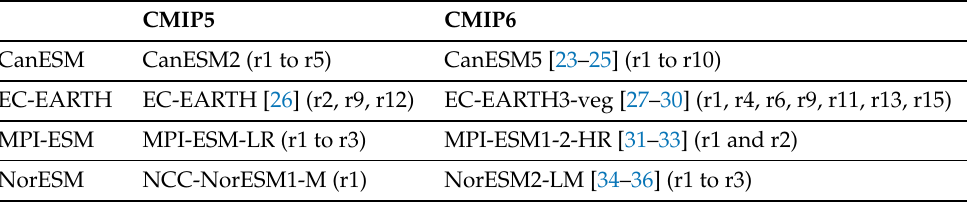
Table 2. Overview of the GCMs analysed for the two scenario pairs RCP4.5 + SSP2-4.5 and RCP8.5 + SSP5-8.5, respectively. Note that the second model run for MPI-ESM1-2-HR under SSP2-4.5 is currently